Question: Reading the figure, is the described quantity rising or falling?
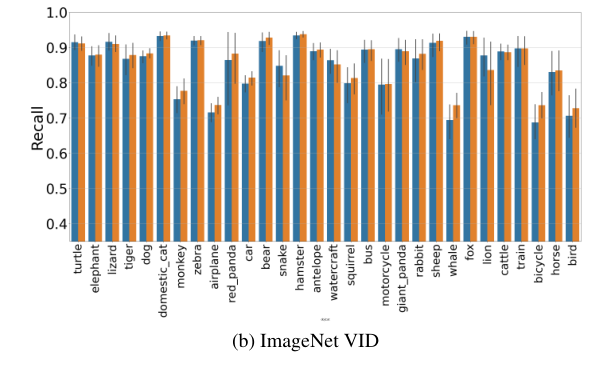
Answer: increasing